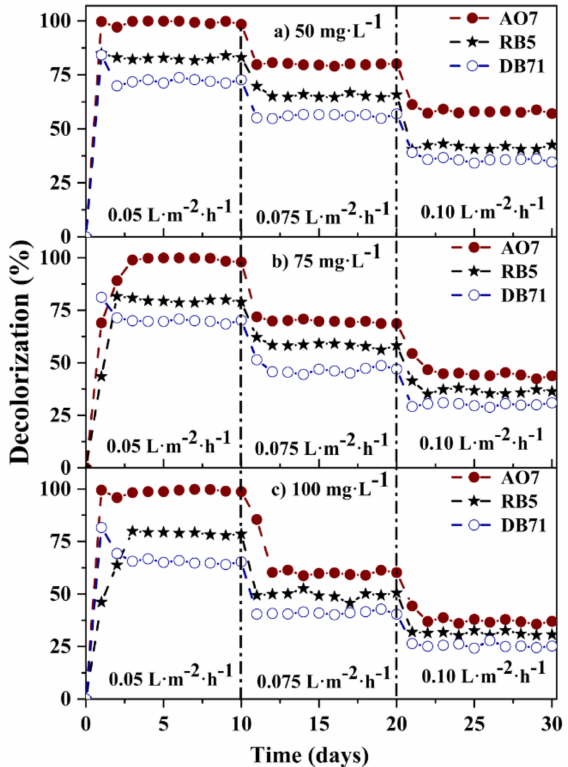
Figure 8. Decolorization of AO7, RB5, and DB71 dyes at different concentrations and fluxes; ( a ) 50 mg · L − 1 , ( b ) 75 mg · L − 1 , and ( c ) 100 mg · L − 1 dye solution at 37 ◦ C. CSCM: 10%